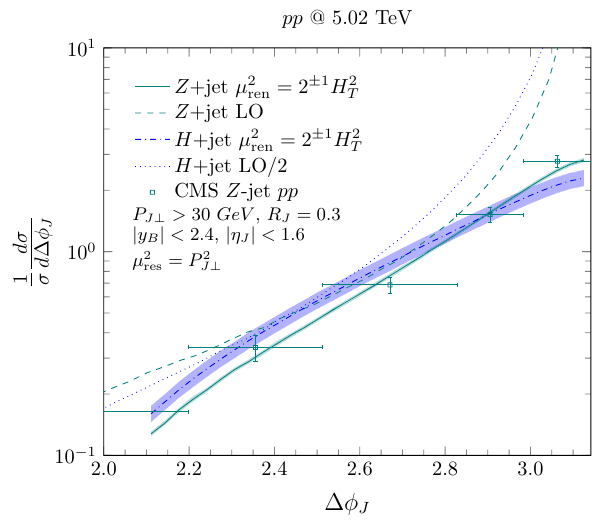
Fig. 5 Normalizedazimuthalangular (cid:2)φ distributionusing resumma- tion and perturbative calculation for Z + jet process (solid and dashed) and H + jet process (dashdotted and dotted) at 5.02 TeV. Data from the CMS [60] experiment is shown in comparison